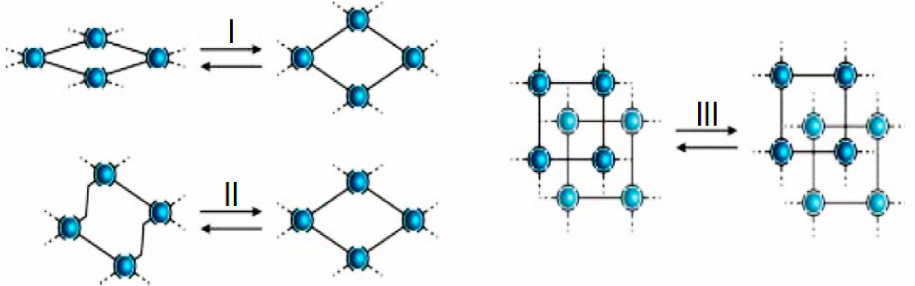
Figure 3. Types of breathing: (I) flexibility of the inorganic building units (IBUs), (II) structural changes of the linker molecules, and (III) shift of interpenetrated or interwoven frameworks